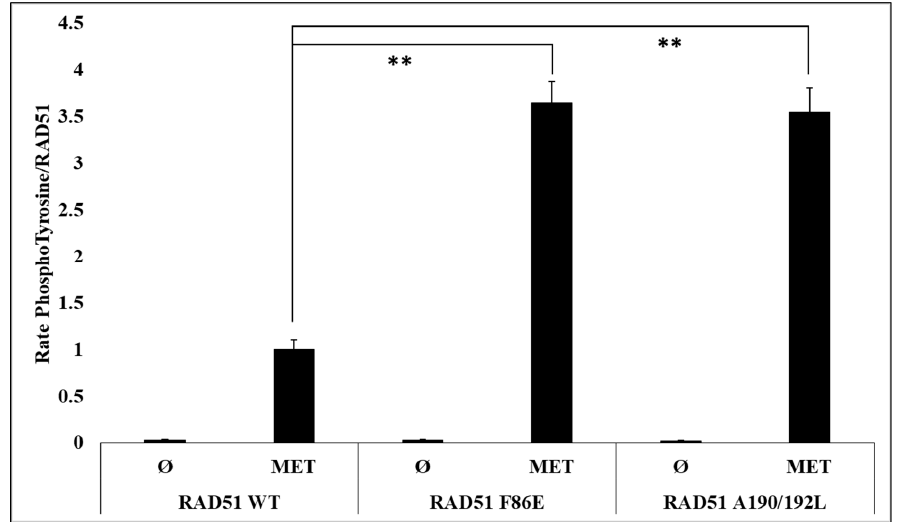
Figure 4. Phosphorylation level is promoted for monomeric RAD51 mutant variants. The RAD51 WT protein (10 µ M) and all non-polymerizable mutants of RAD51: F86E and A190/192L [26] were purified and incubated in the presence of kinase-active c-MET (0.1 µM) and ATP (2 mM). Then, the proteins were separated by SDS-PAGE 12% gel and analyzed by western blot using anti-RAD51 and anti-phosphotyrosine antibodies. The signals were quantified with the Odyssey scanner and compared with the signal from RAD51 WT. The graph represents the phosphorylation rate of each mutant compared to the wild type protein following the quantification of blots from three independent experiments (ø: without kinase) ( n = 3; error bars: s.d.; ** p < 0.01). The RAD51 protein is normally present in monomer-oligomer equilibrium